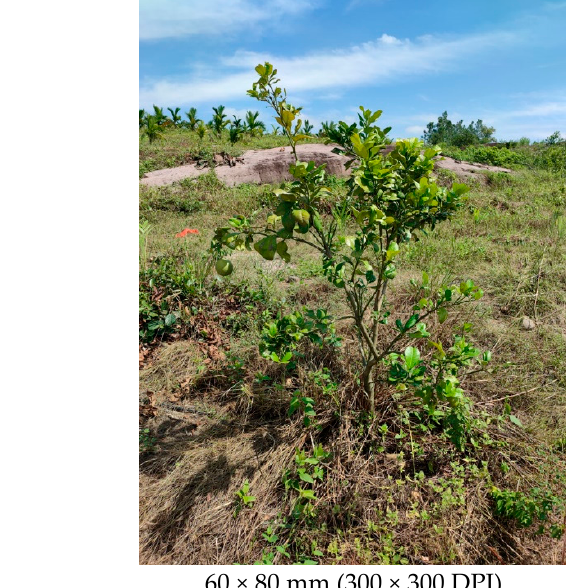
Figure 1. The disease symptoms of Citrus maxima that occur on Hainan Island in China.